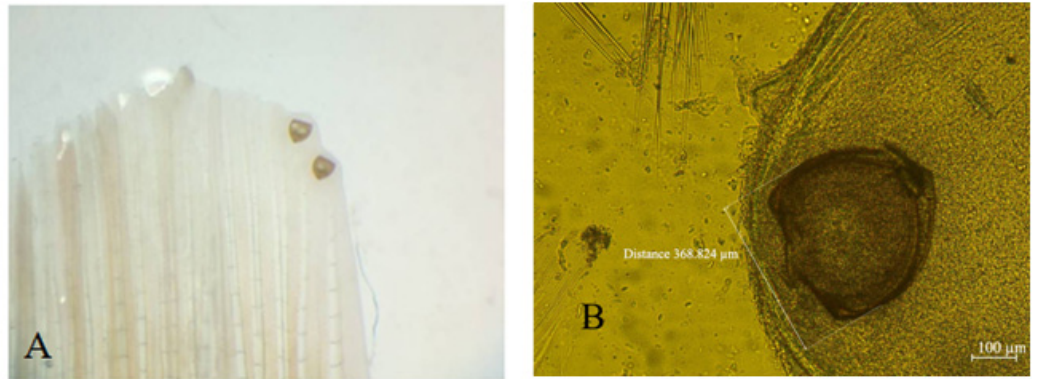
Figure 3. Glochidia of Anodonta cygnea on the fins of Rutilus prespensis from the Macedonian part of Lake Prespa—original photos: ( A )—Glochidia found on the fin of a fresh Rutilus prespensis specimen; ( B )—microscopic slide of Glochidia.